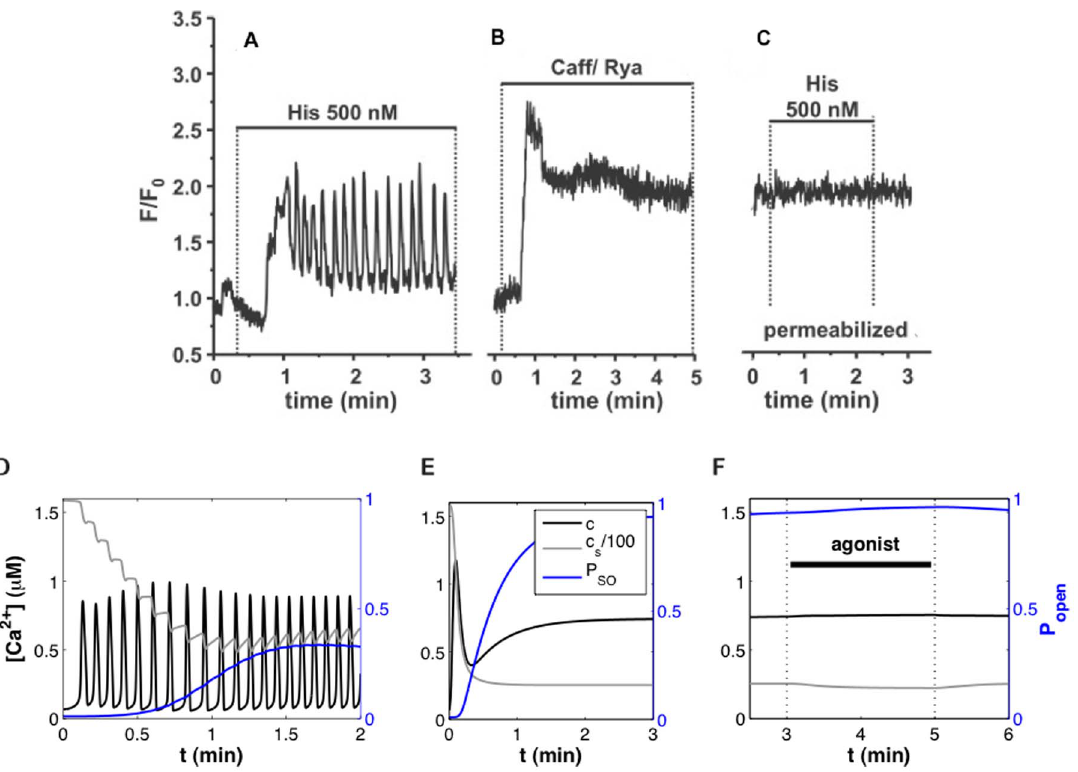
dynamics in an ASMC within a human i i